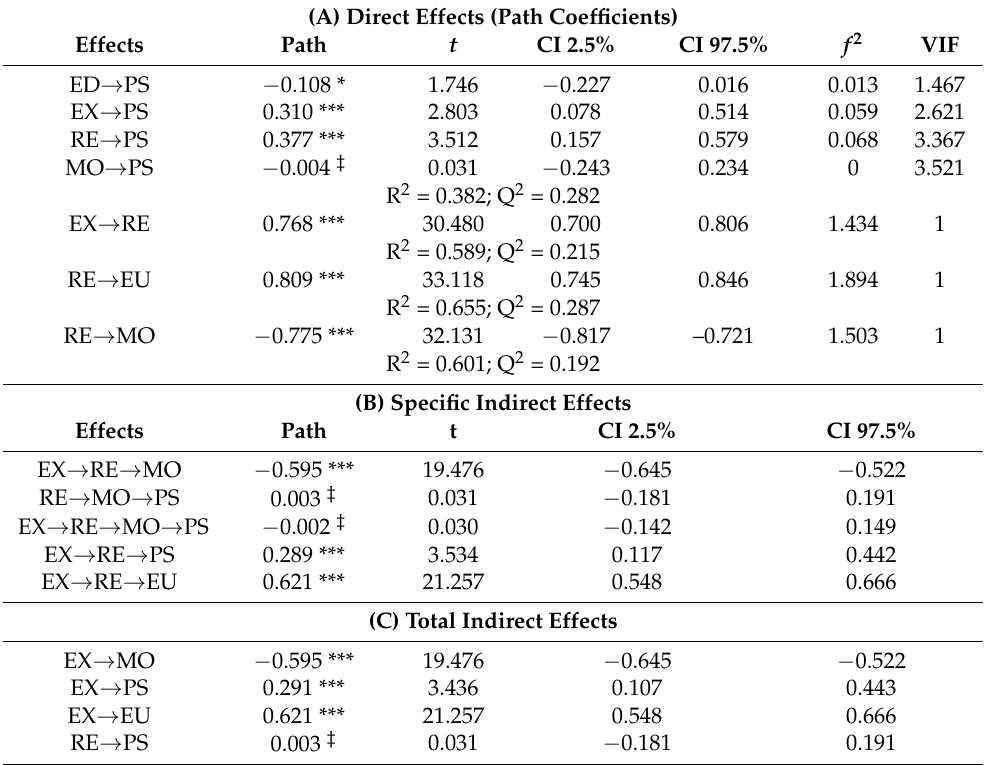
Figure 2. Whole model results for men.